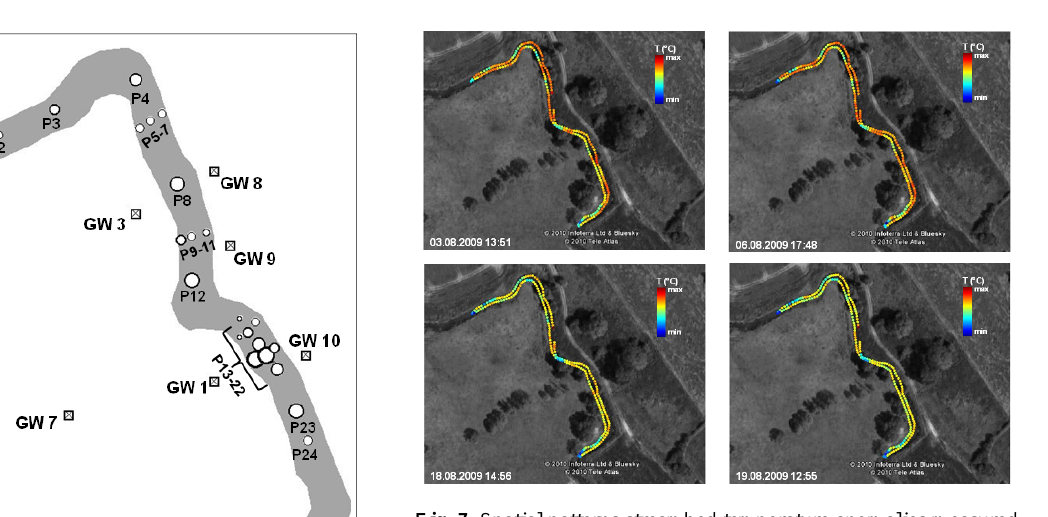
these locations (cold spots) also exhibit more intense tempo-